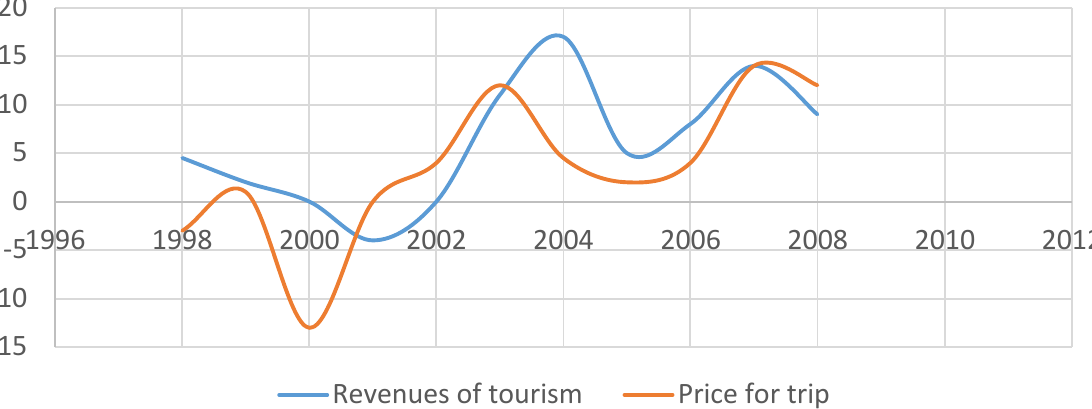
Figure 2. Development of revenues from tourism and the prices for trips for the period 1998–2008 (values representing the average of perceptual year-to-year differences of 23 countries)